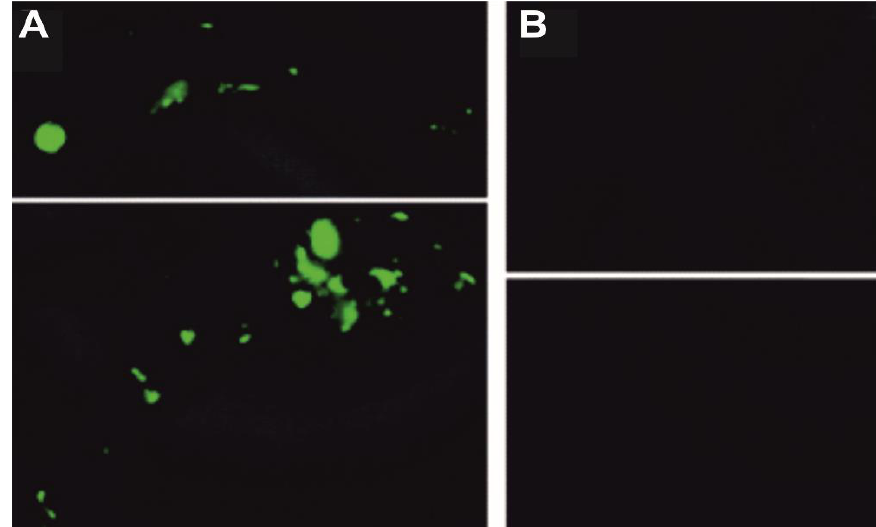
Figure 9. Inhibition of Mmar in a zebrafish model. ( A ) Green fluorescence showing the infection in zebrafish larvae at six days post infection not treated with the inhibitor; and ( B ) zebrafish larvae infected with Mmar and treated with 300 μM Fc14-584b showing the absence of bacteria. The figure is modified from Aspatwar et al. [29].